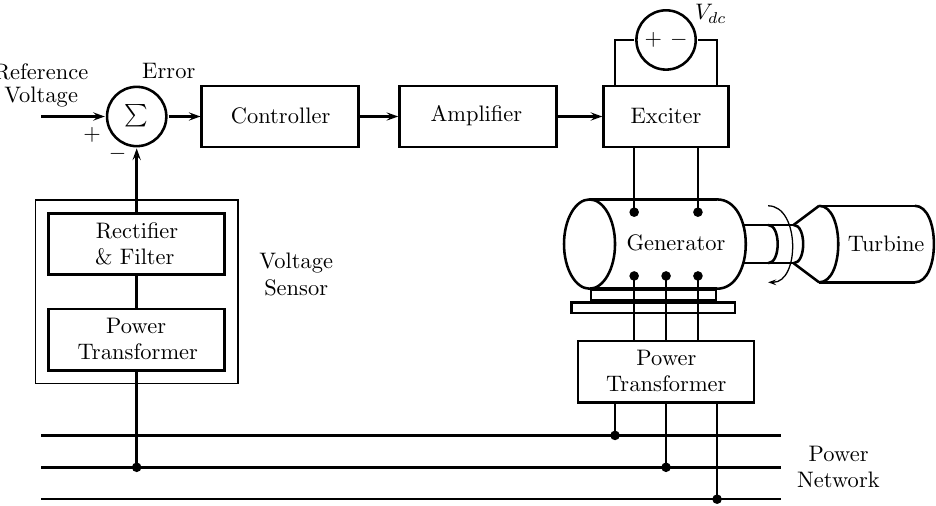
Figure 2. Schematic diagram of an AVR system.